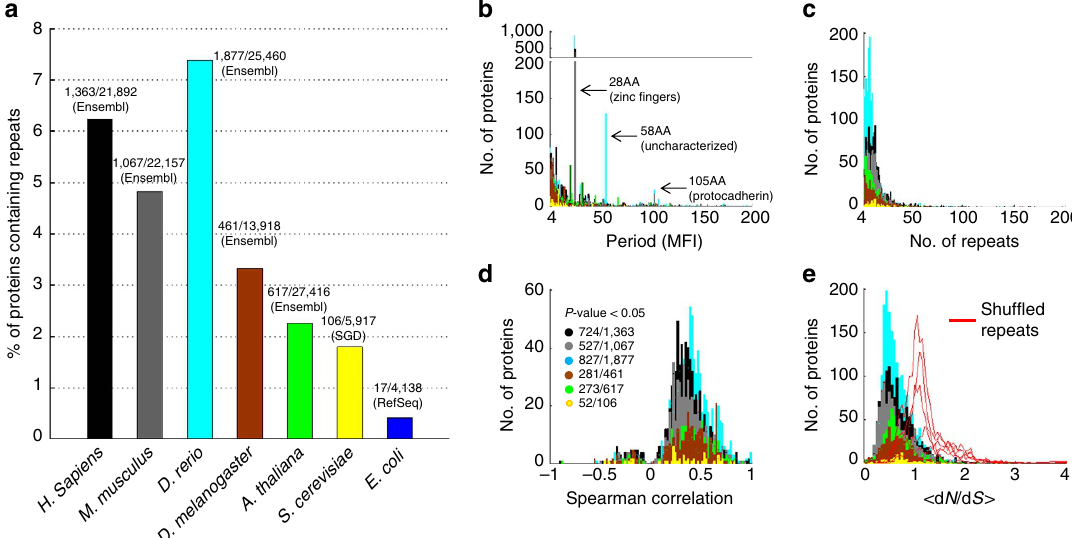
Figure 4 | Protein repeats in diverse organisms. ( a ) Percentage of proteins containing repeats in the studied organisms. Species are arranged by taxonomic order. The colour code, the number of proteins containing repeats relative to the number of unique genes and database sources are shown. ( b ) Distribution of the period lengths demonstrating similarities and differences between the organisms. ( c ) Distribution of the number of repeats in each organism. ( d ) Distribution of the Spearman correlation coefficients between evolutionary and physical distances of the repeats in each protein. ( e ) Distribution of o d N/ d S 4 values for horizontal comparisons of repeats from different organisms (colour coded) compared with the respective distributions of shuffled repeats (red